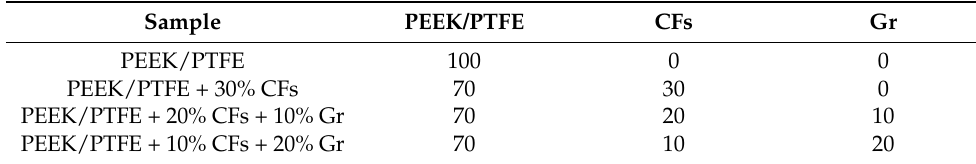
Table 1. The composition of the composites